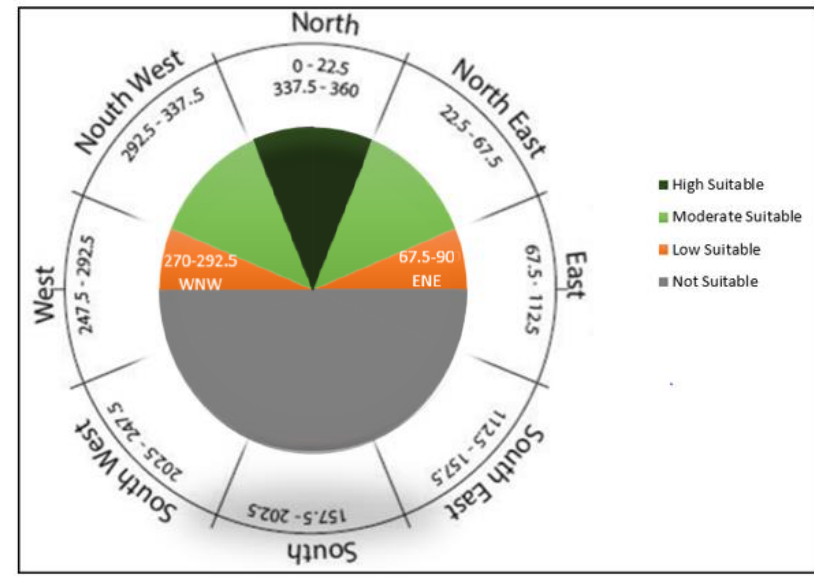
Figure 3. Suitable aspect directions for PV power plant.